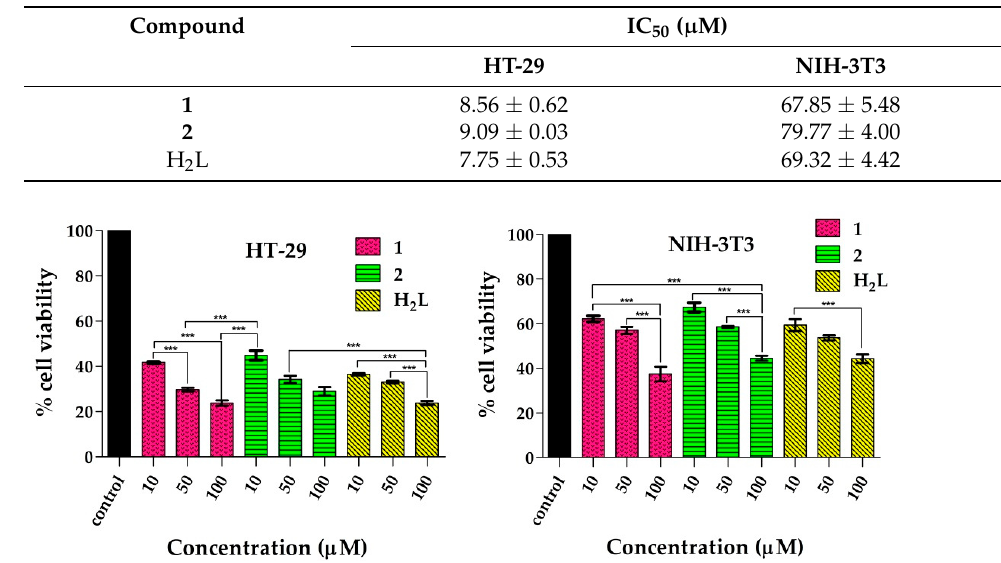
Table 4. IC 50 values of H 2 L and Complexes ( 1 and 2 ) taking 10, 50, and 100 µ M concentrations.